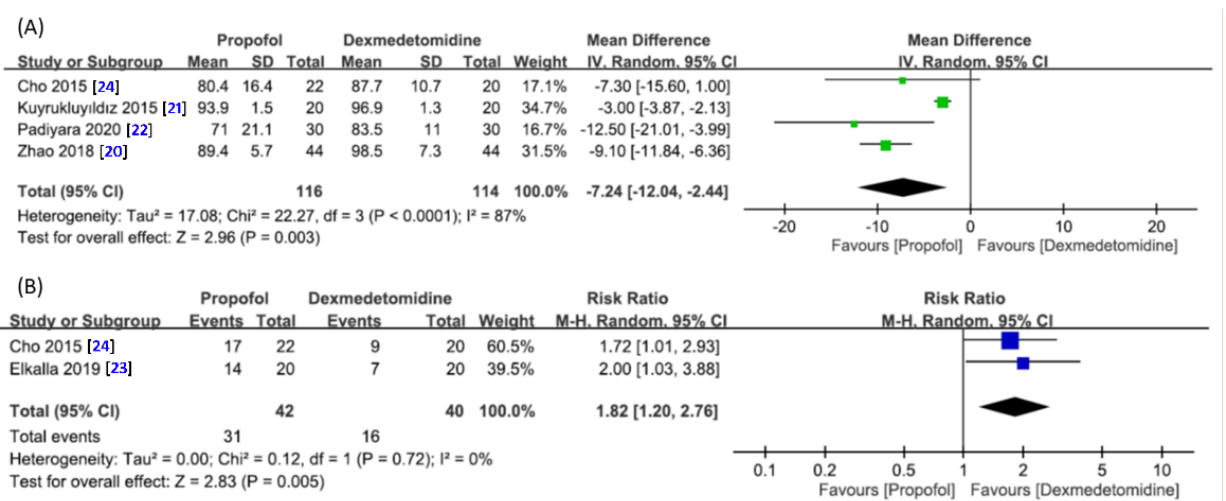
Figure 5. Forest plot for comparing the risk of failed sedation for drug-induced sleep en- doscopy between propofol and dexmedetomidine groups. CI, confidence interval; M–H, Mantel–Haenszel.